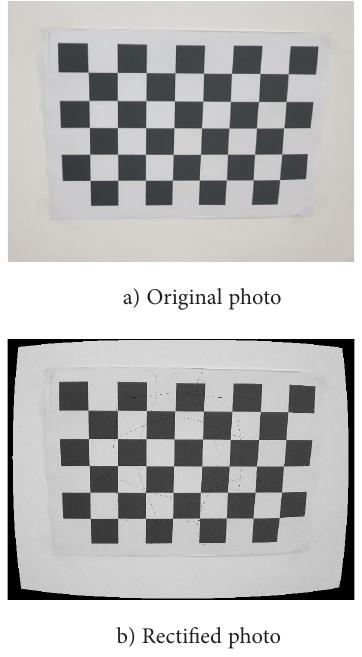
Figure 5. Image rectification for a photo sample captured from telephoto lens